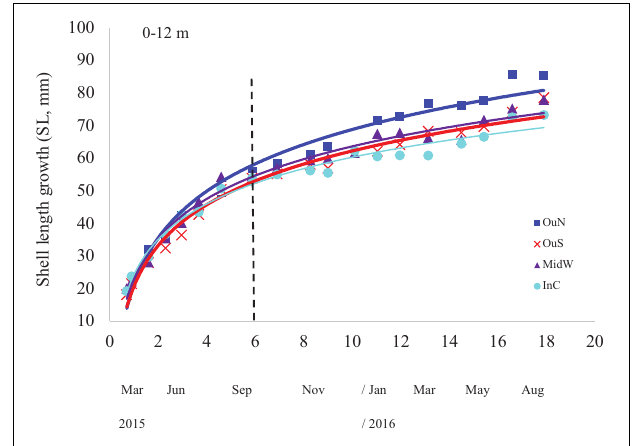
FIGURE 6 | Shell length growth curves for the cultivated mussels at the distinct experimental sites of the Ría de Arousa and considering the whole length of the cultivation rope (0–12 m). The dashed line represents the timing of the thinning out process usually carried out between seeding and harvest.